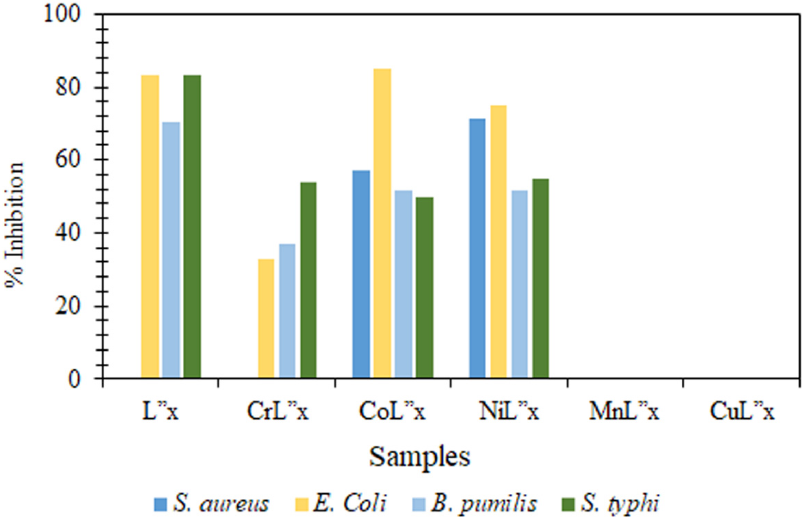
Figure 6. Comparative Histograms Showing Inhibition Zone in Antibacterial Assays of Compounds 3 – 8 .